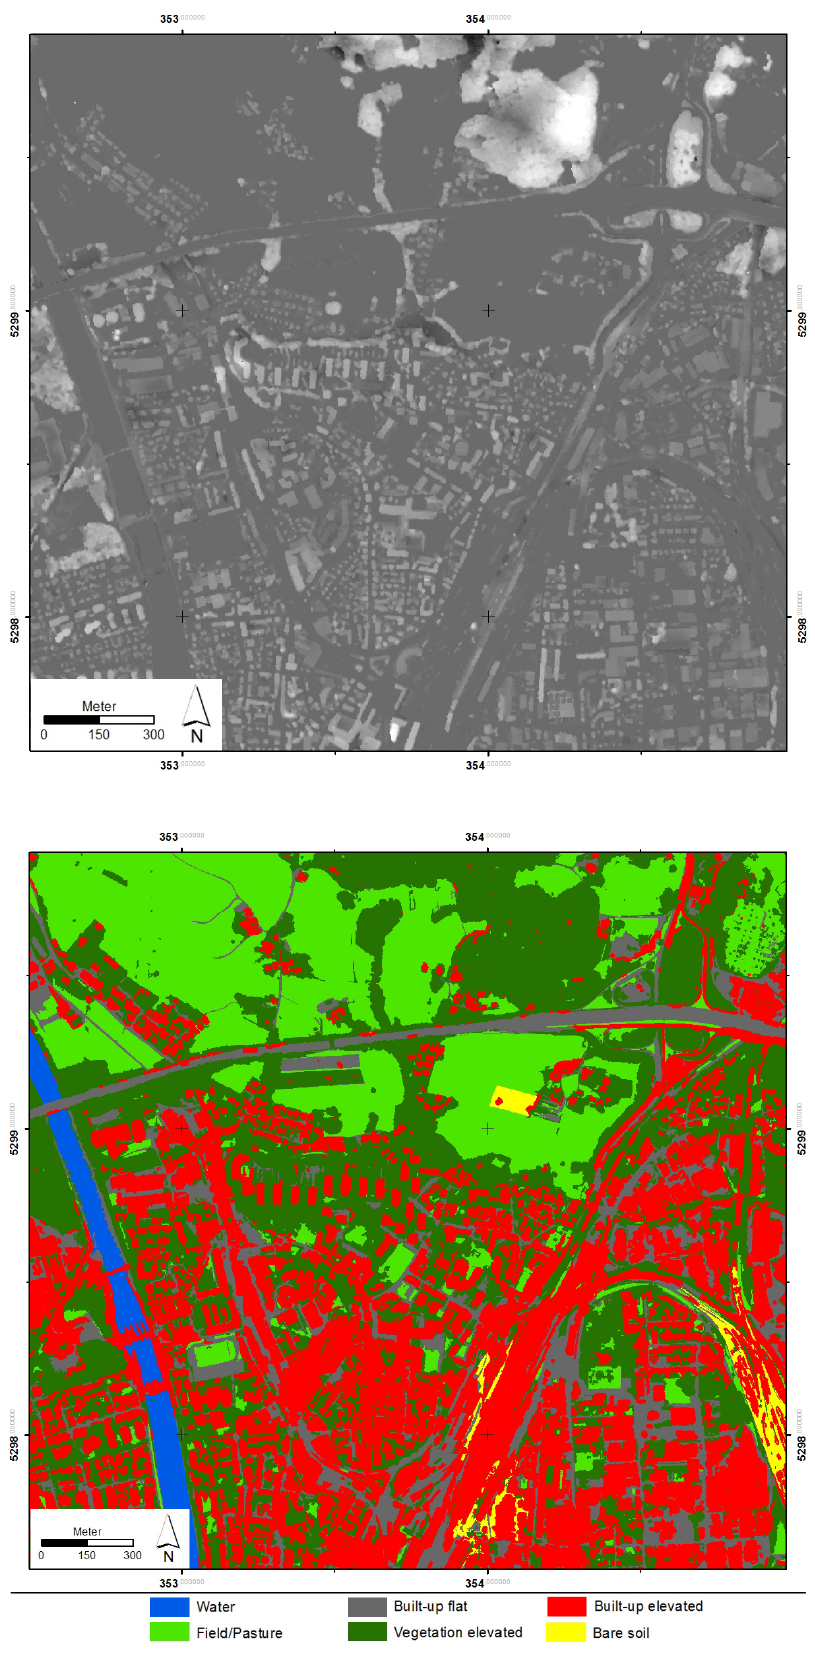
Figure 6. Top : normalized DSM (nDSM) generated from stereo DSM and the generated DEM; Bottom : land cover classification of the study